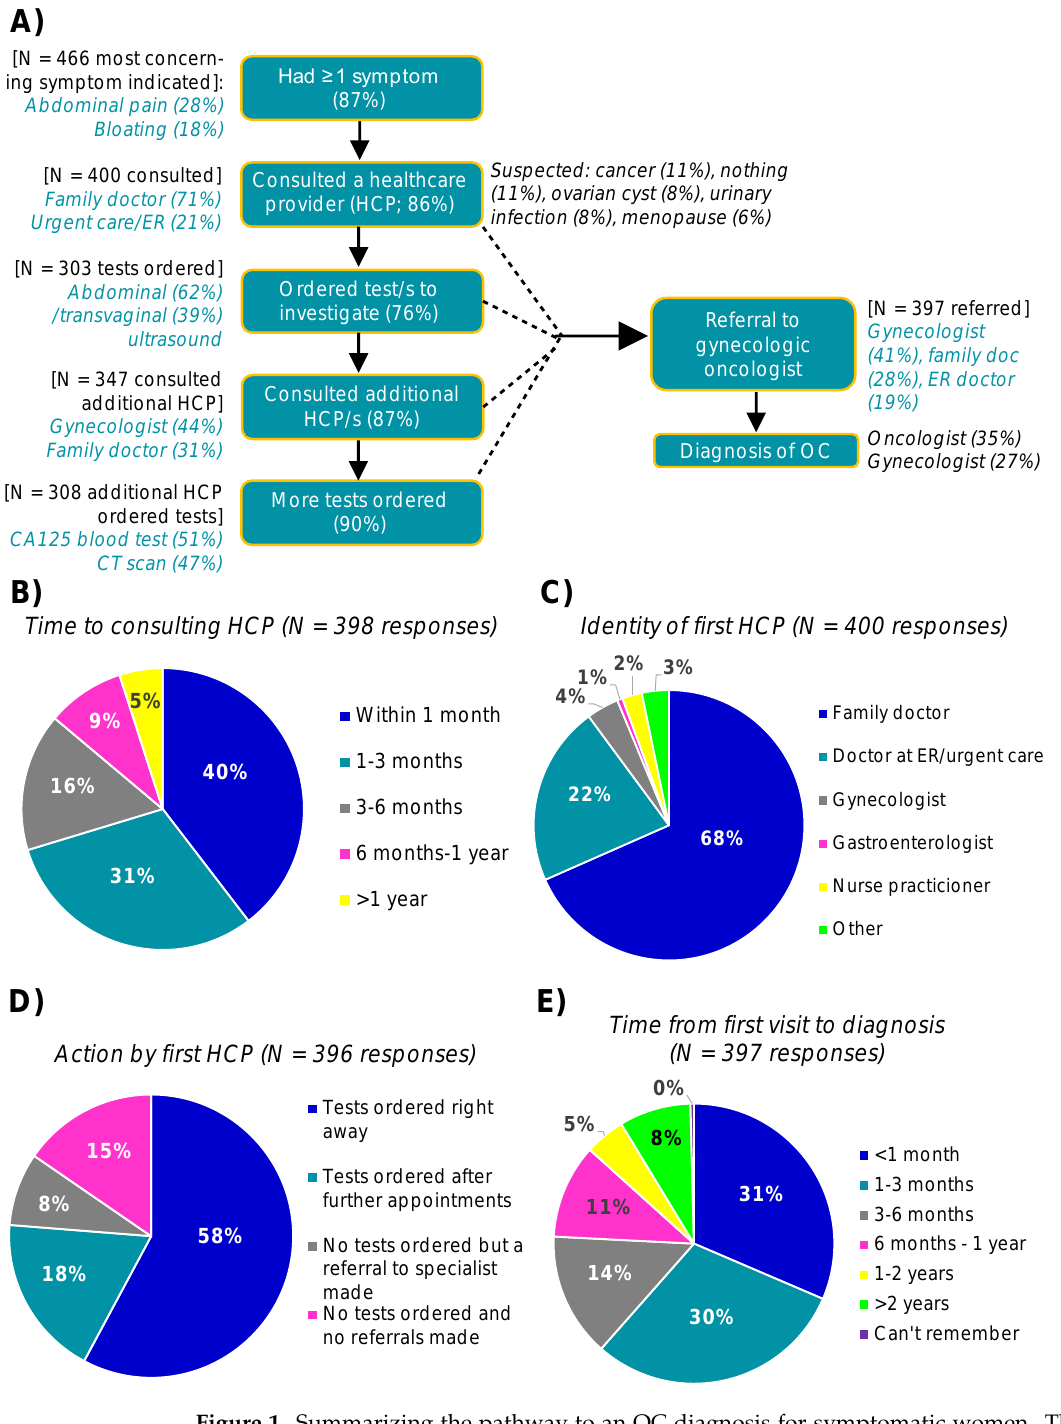
Figure 1. Summarizing the pathway to an OC diagnosis for symptomatic women. The pathway from initial experience of symptoms through to diagnosis is shown in panel ( A ), with the most common responses at each step highlighted. The breakdown of responses for time to consulting a healthcare provider about symptoms ( B ), identity of the first healthcare provider ( C ), action by the first healthcare provider in terms of ordering tests ( D ) and the time from first visit to OC diagnosis ( E ) are shown. Abbreviations: HCP—healthcare provider; OC—ovarian cancer.